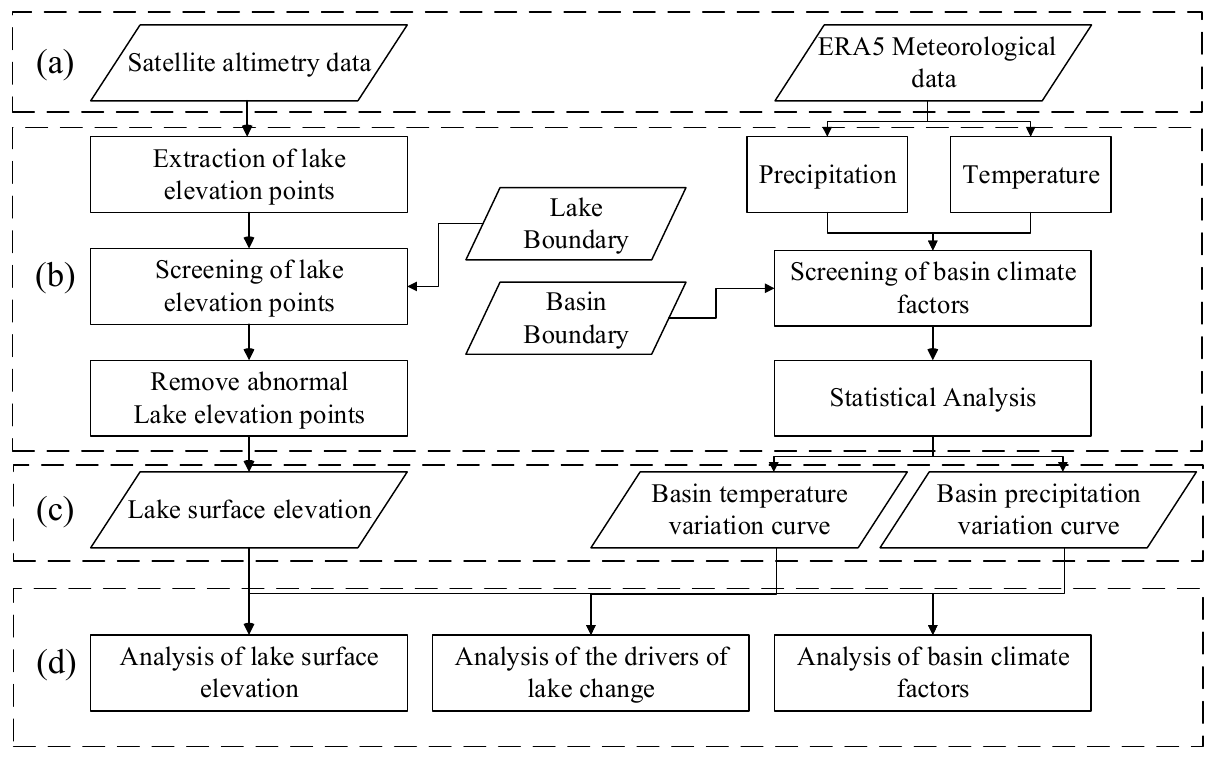
Figure 3. Technical flow chart. ( a ) Data source. ( b ) Data processing process. ( c ) Lake surface elevation and basin temperature precipitation profiles. ( d ) Trend and driver analysis of lake variability.